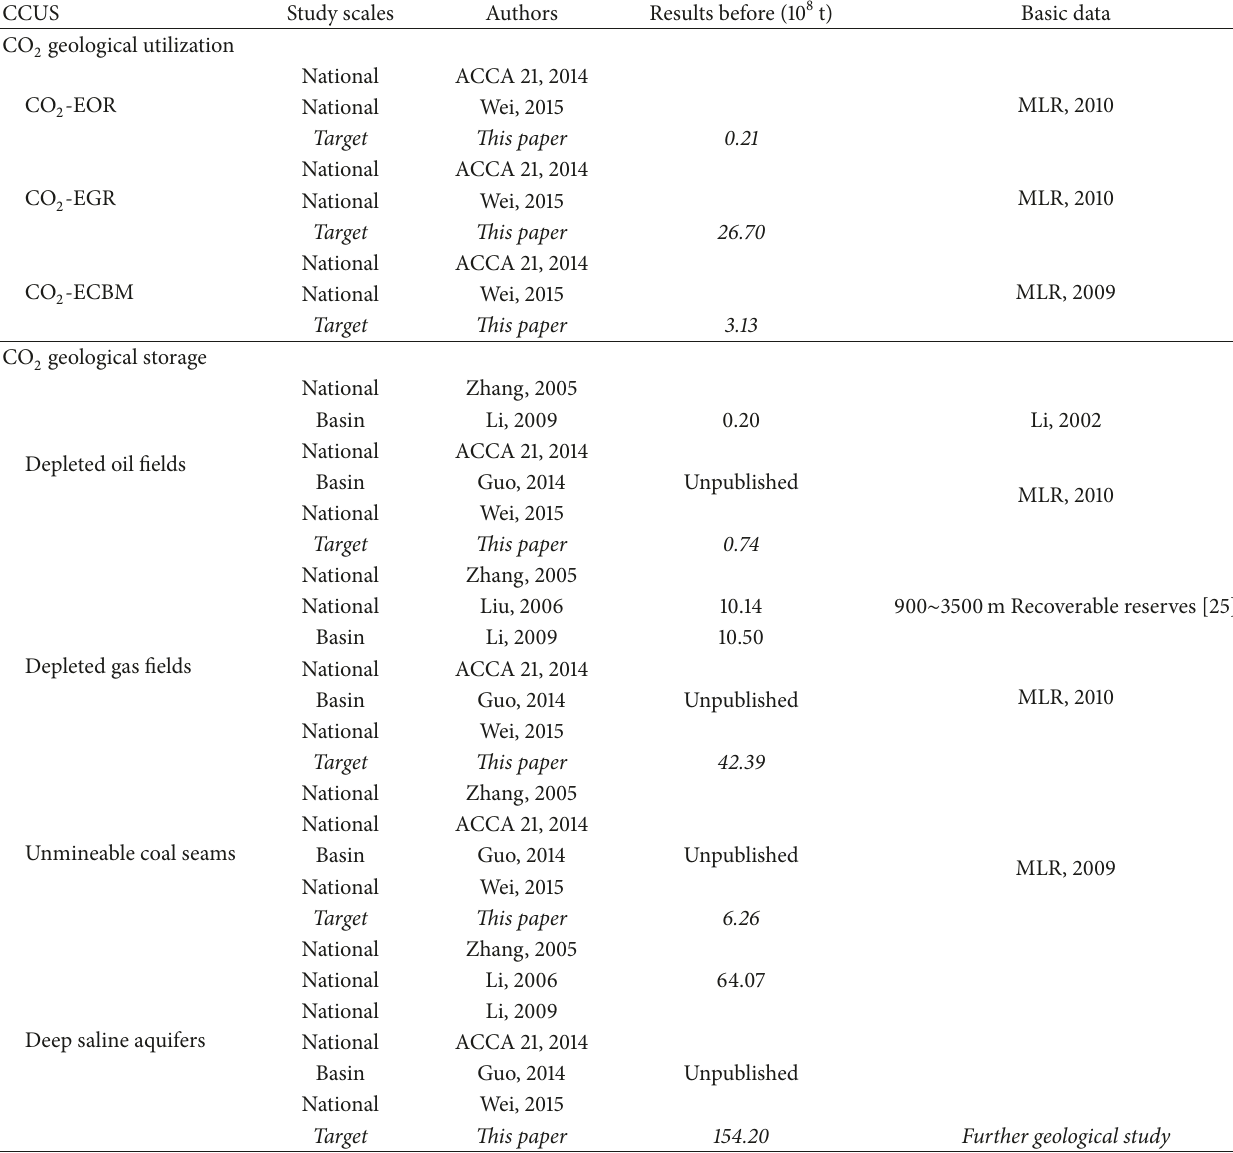
Table 13: Storage potential results in this paper compared with studies